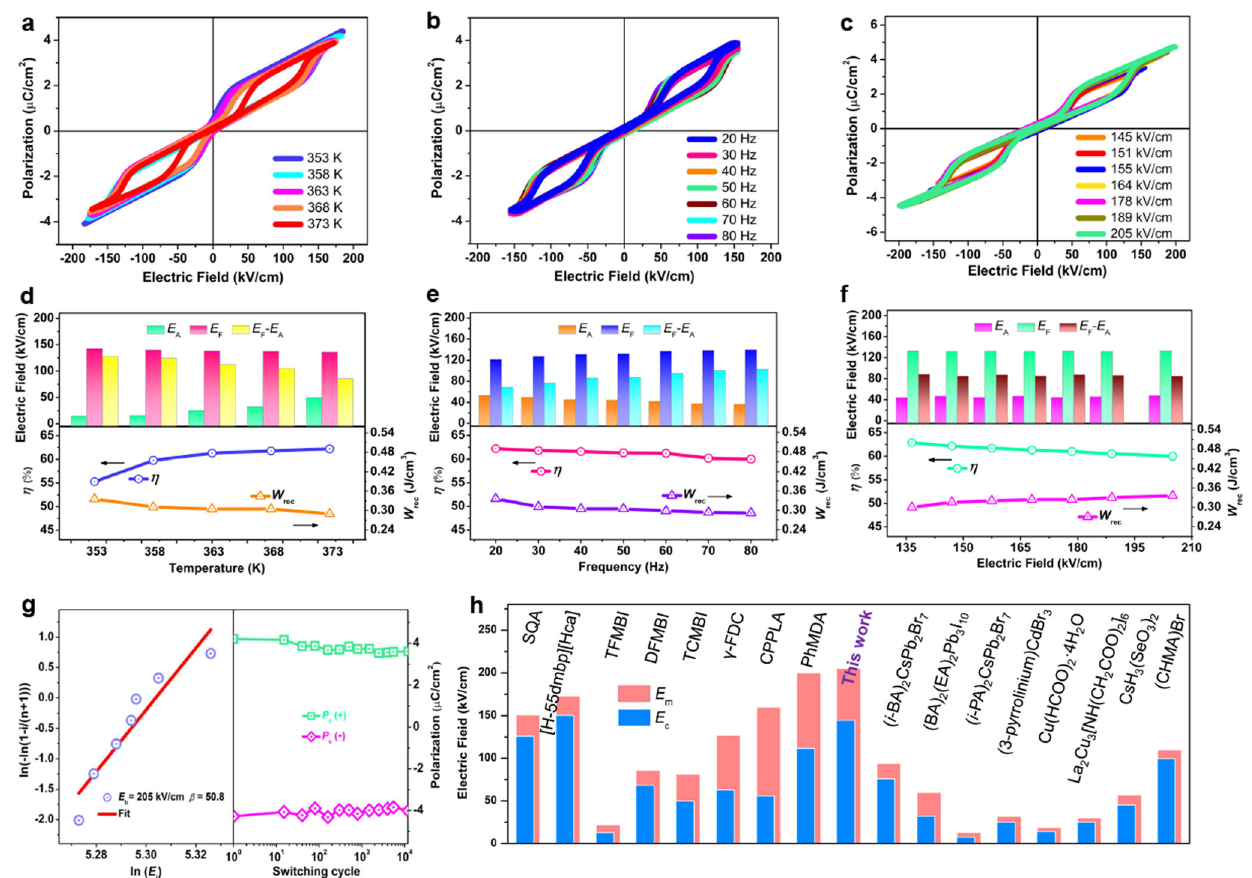
Fig. 6 | The AFE properties and energy storage performances of 1 under dif- ferent conditions. The typical P-E double hysteresis loops collected at different, a temperatures, b frequencies and c electric fi elds, respectively. The antiferroelectricity-directed electric hysteresis Δ E , energy storage densities W rec